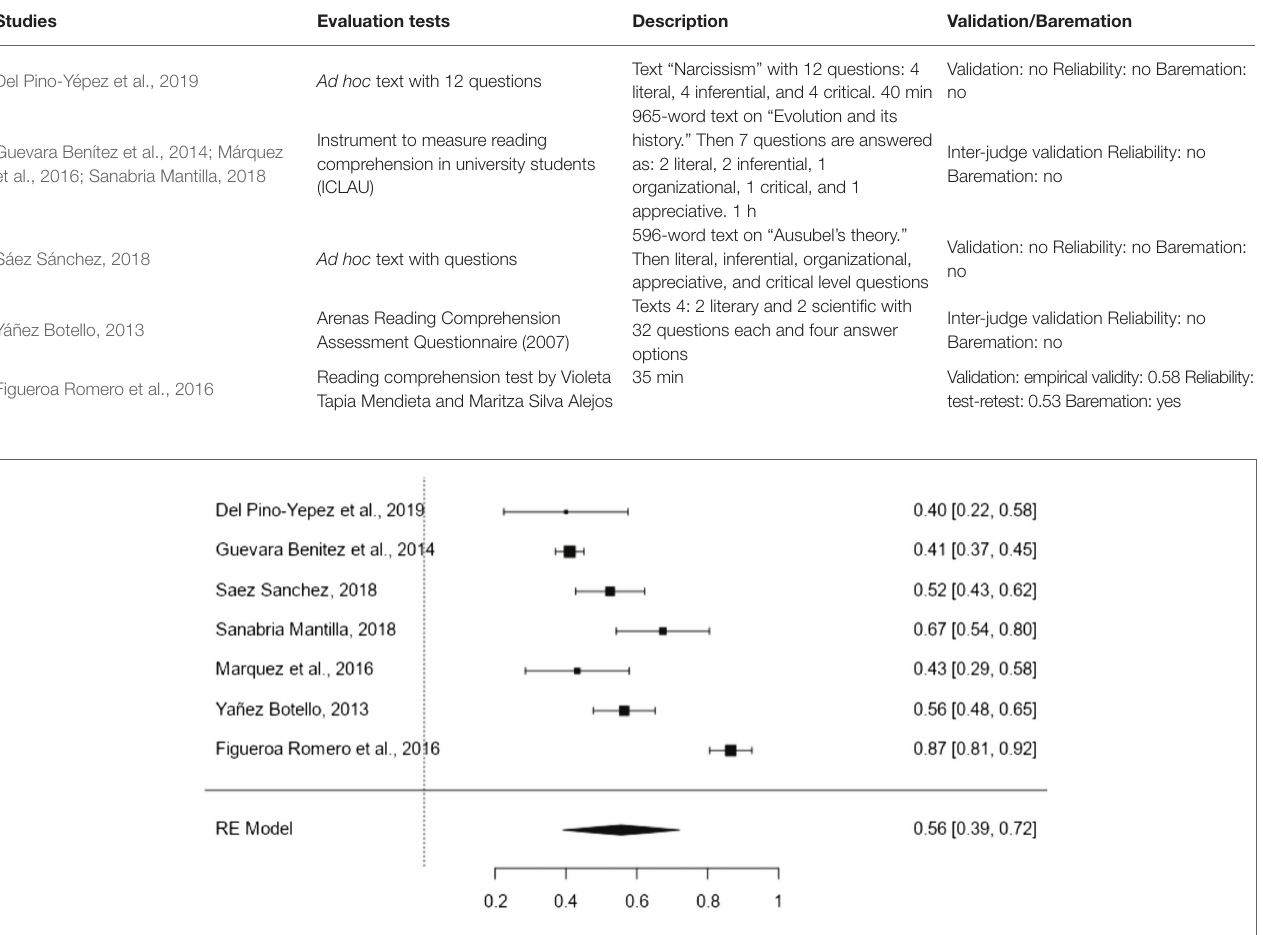
FIGURE 2 | Forest plot of literal